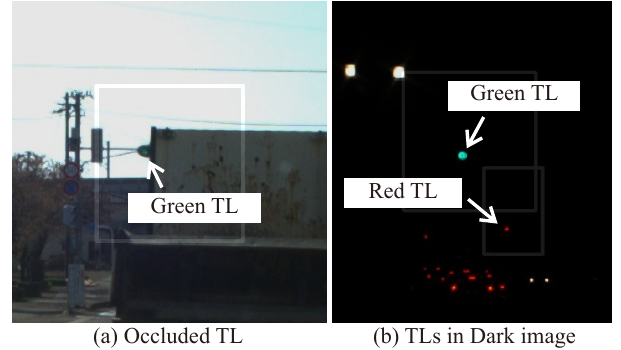
Figure 4. Typical traffic light (TL) images in occluded and dark